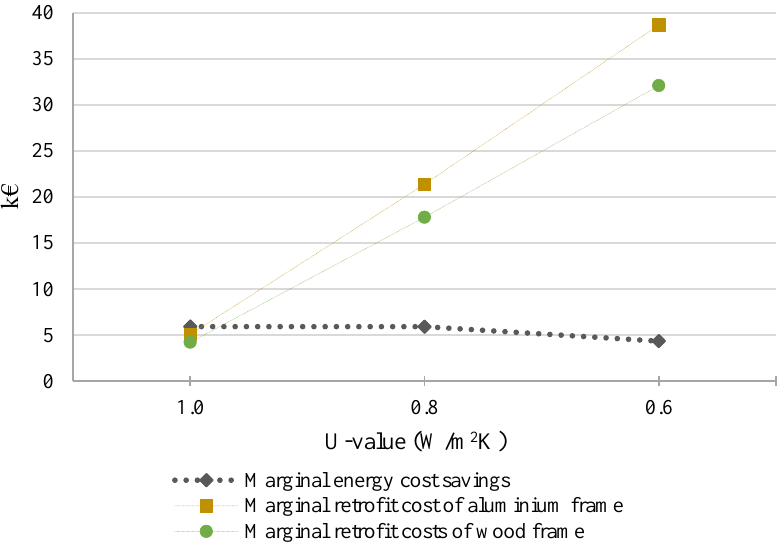
Figure 5. Marginal energy cost savings and marginal retrofit costs of extra insulation on basement walls using polystyrene (XPS).